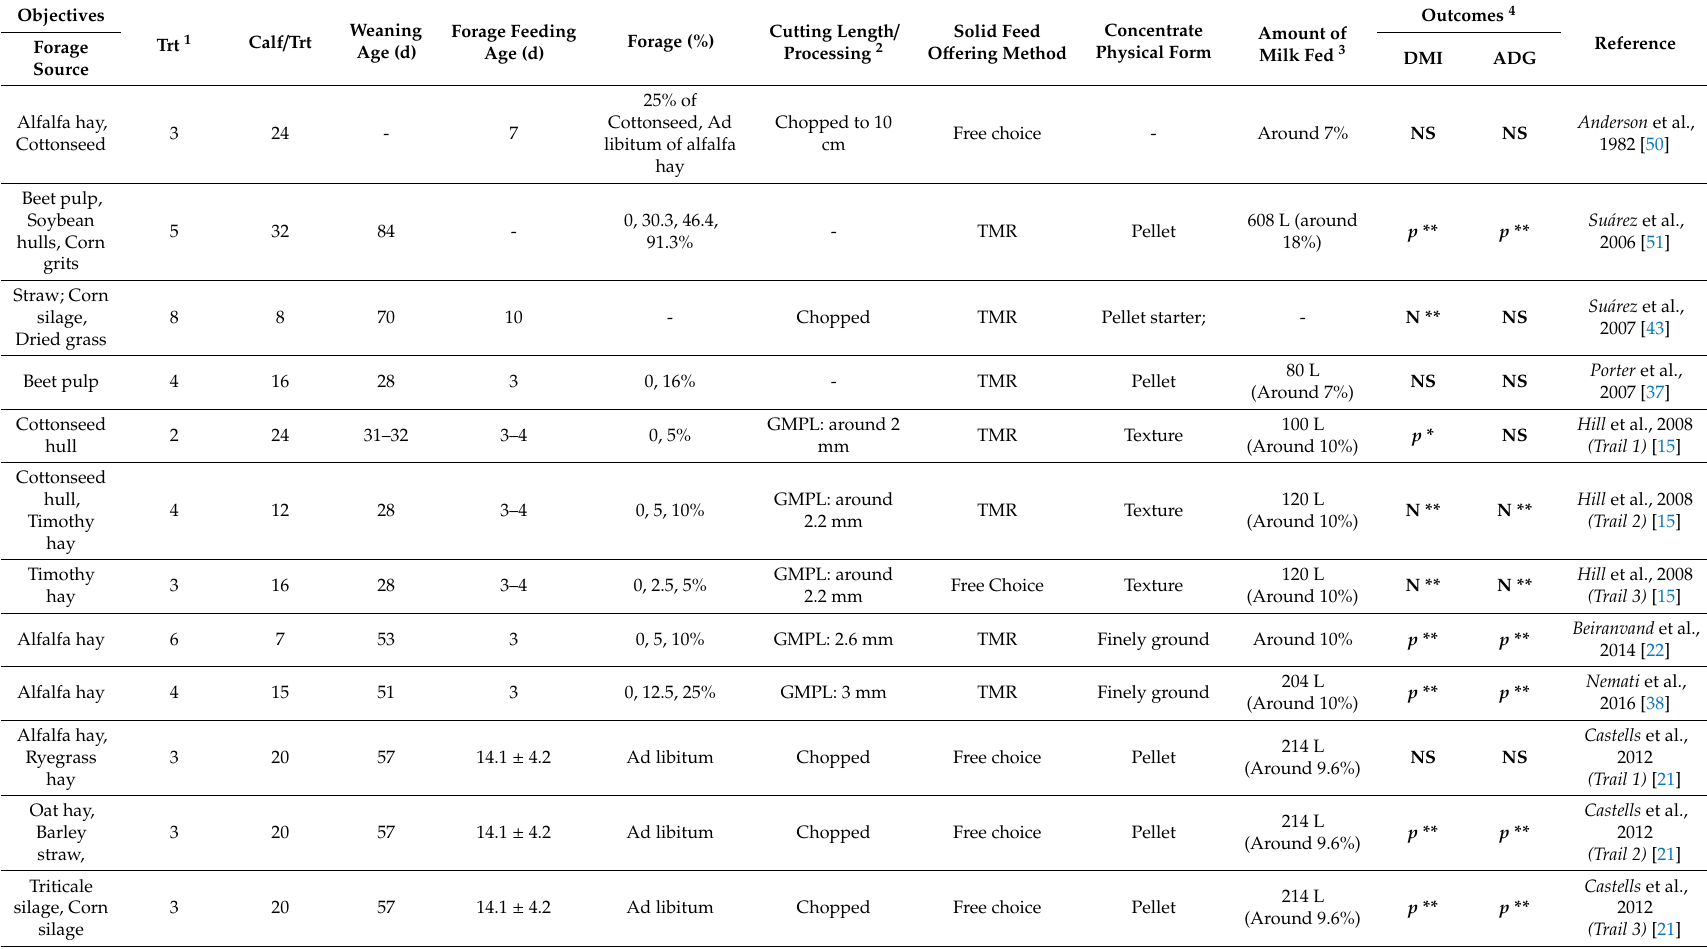
Table 2. A summary of studies feeding di ff erent forage sources in pre-weaned dairy